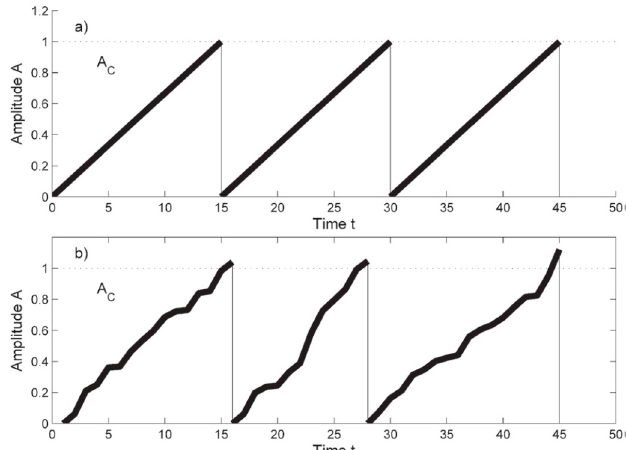
Figure 5. Illustration of an integrate and fire (IAF) oscillator. ( a ) the case where the amplitude A ( t ) of an IAF oscillator integrates linearly in time until it reaches a critical value Ac, after which it discharges by setting A ( t ) = 0. The case in ( a ) can be viewed as one IAF oscillating over three periods of time, or equivalently, three identical and uncoupled IAF oscillators oscillating over one period of time; ( b ) an IAF oscillator with random frequency over three time periods, or, equivalently, three different unit oscillators with random frequency over one time period. The figure is taken from (Liu et al. 2017).